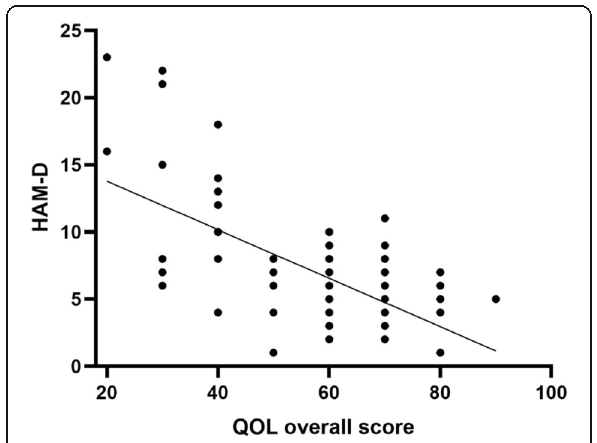
Fig. 1 Correlation between overall QOL and HAM-D scale. Significant moderate negative correlation between overall QOL and HAM-D scale, r = − 0.617, P < 0001